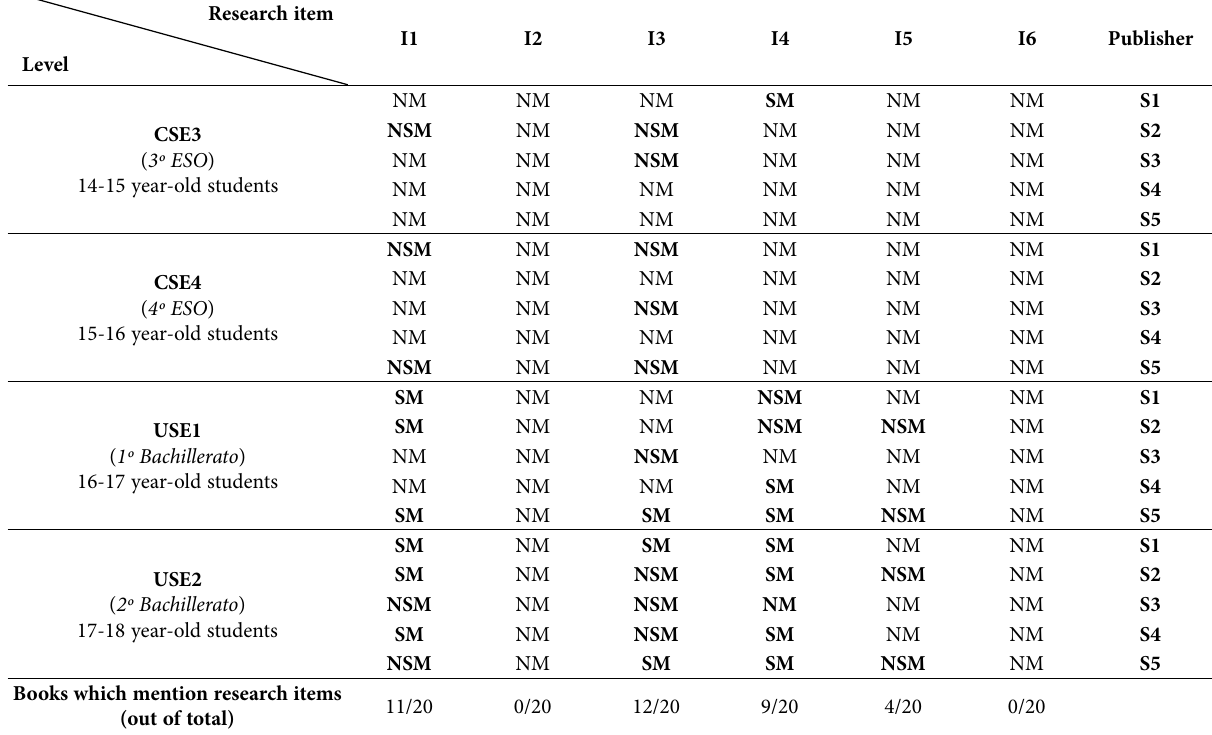
Table 5. Results from categorization of Spanish texts on the history of the periodic system. SM, satisfactory mention; NSM, non-satisfactory mention; NM, no